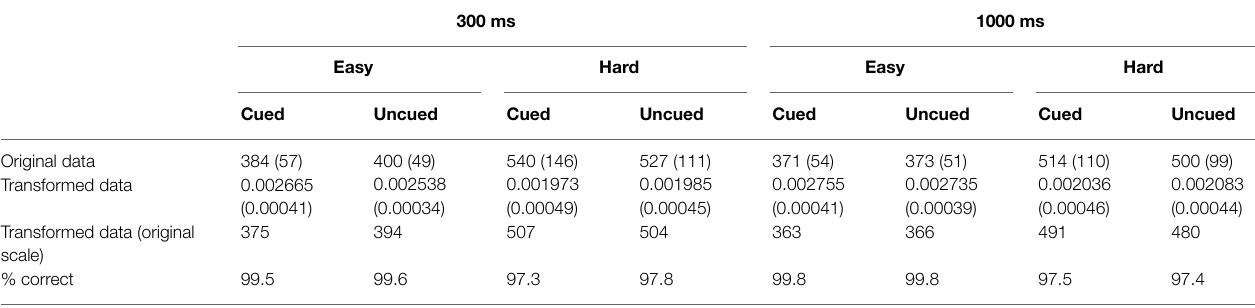
TABLE 1 | Means and standard deviations (in parentheses) of responses in each condition of Experiment